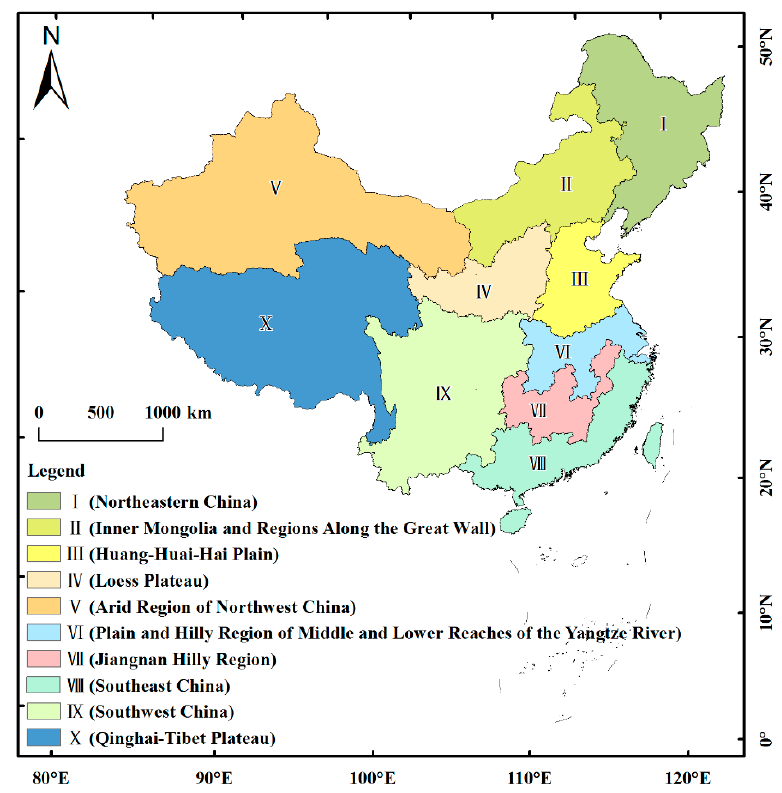
Figure 1. Location of the study area (Chinese mainland).